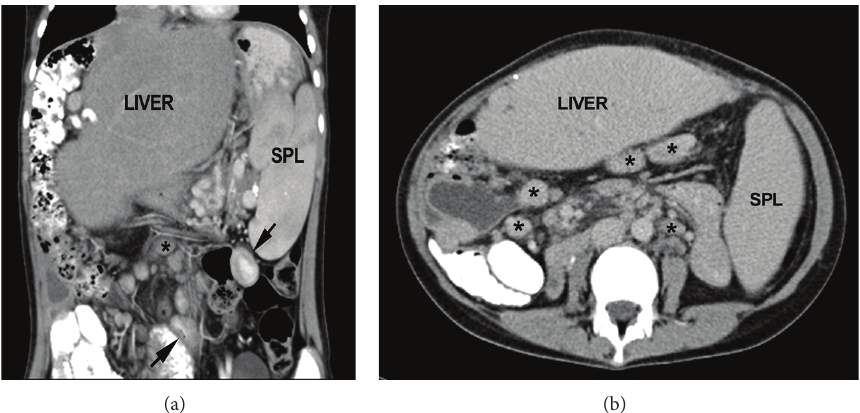
Figure 1: Axial (a) and coronal reformats of contrast-enhanced abdominal CT showing marked enlargement of the spleen and transplanted liver, multiple moderately enlarged mesenteric and gastrohepatic ligament lymph nodes ( ∗ ), and focal small bowel wall thickening